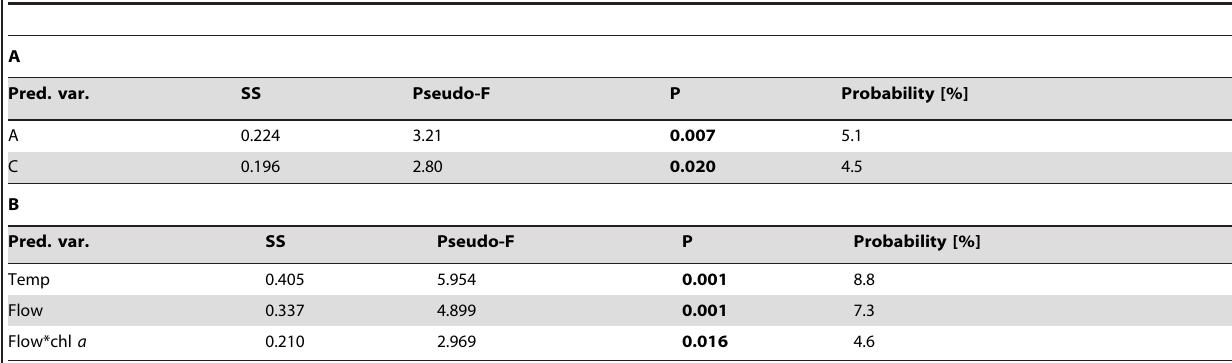
Table 1. Relationship between zooxanthellae characteristic (response variable – resemblance matrix) and A ) clade composition (predictor variable – resemblance matrix), and B ) environmental parameter (predictor variable) (DISTLM results).